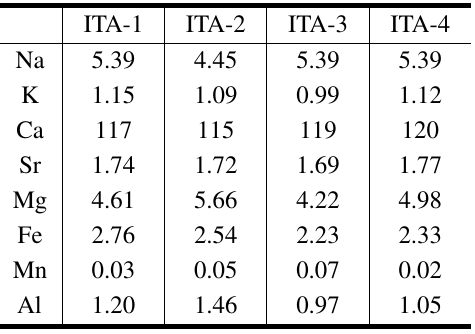
Minor and trace elements (ppm) of beachrock cements from Jaguaribe beach in Itamaracá island (Chaves